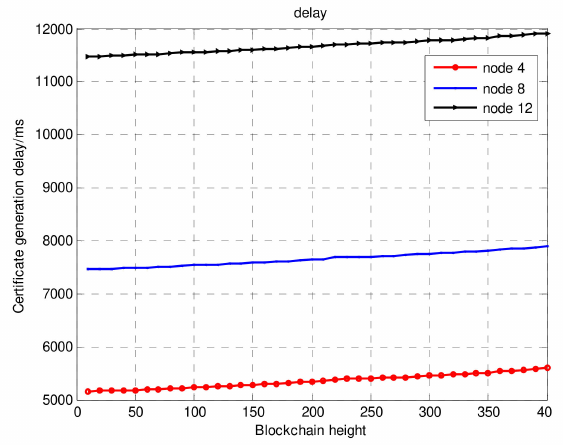
Figure 9. The registration phase delay under different numbers of